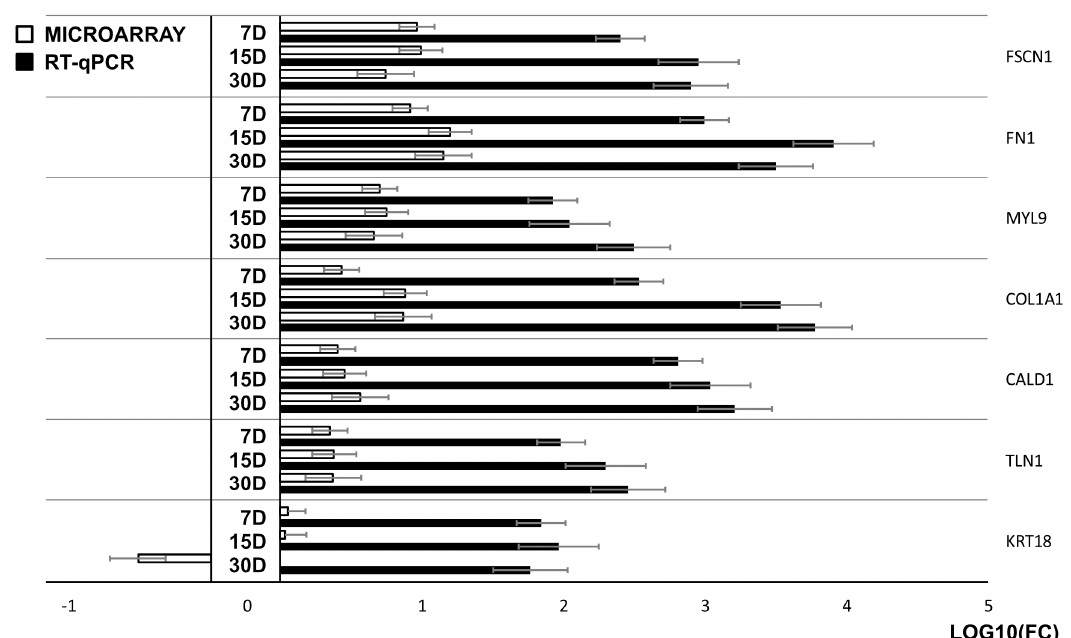
Figure 6. The results of the microarray and real-time quantitative polymerase chain reaction (RT-qPCR) analyses presented in a form of a bar graph.